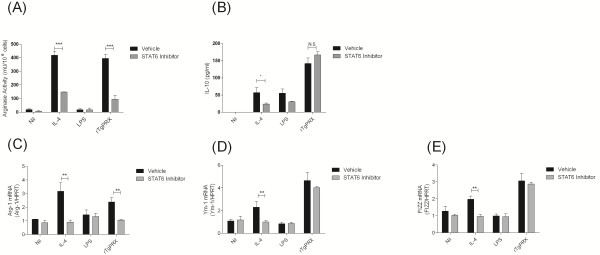
STAT6 dependent and independent functions of rTgPrx. Cells were treated with the STAT6 inhibitor leflunomide for 30 min prior to stimulation or with vehicle control. (A) Cell lysates were used to determine the arginase activity by enzymatic assay. (B) IL-10 levels from supernatants weremeasured by ELISA. (C, D, & E) PCR for FIZZ (C), Ym1 (D), and Arg-1 (E) was carried out on RNA isolated from stimulated cells after 16 h. ***p < 0.001 values represent a mean of triplicate wells ± SD; experiments were repeated three times with similar results.